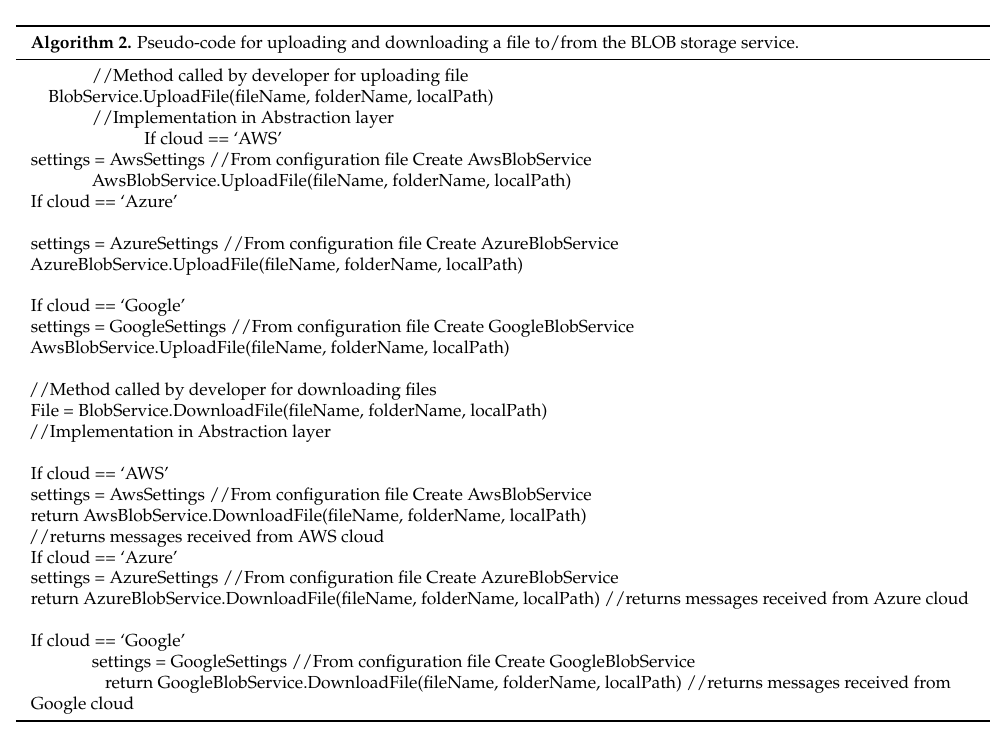
Algorithm 2. Pseudo-code for uploading and downloading a file to/from the BLOB storage